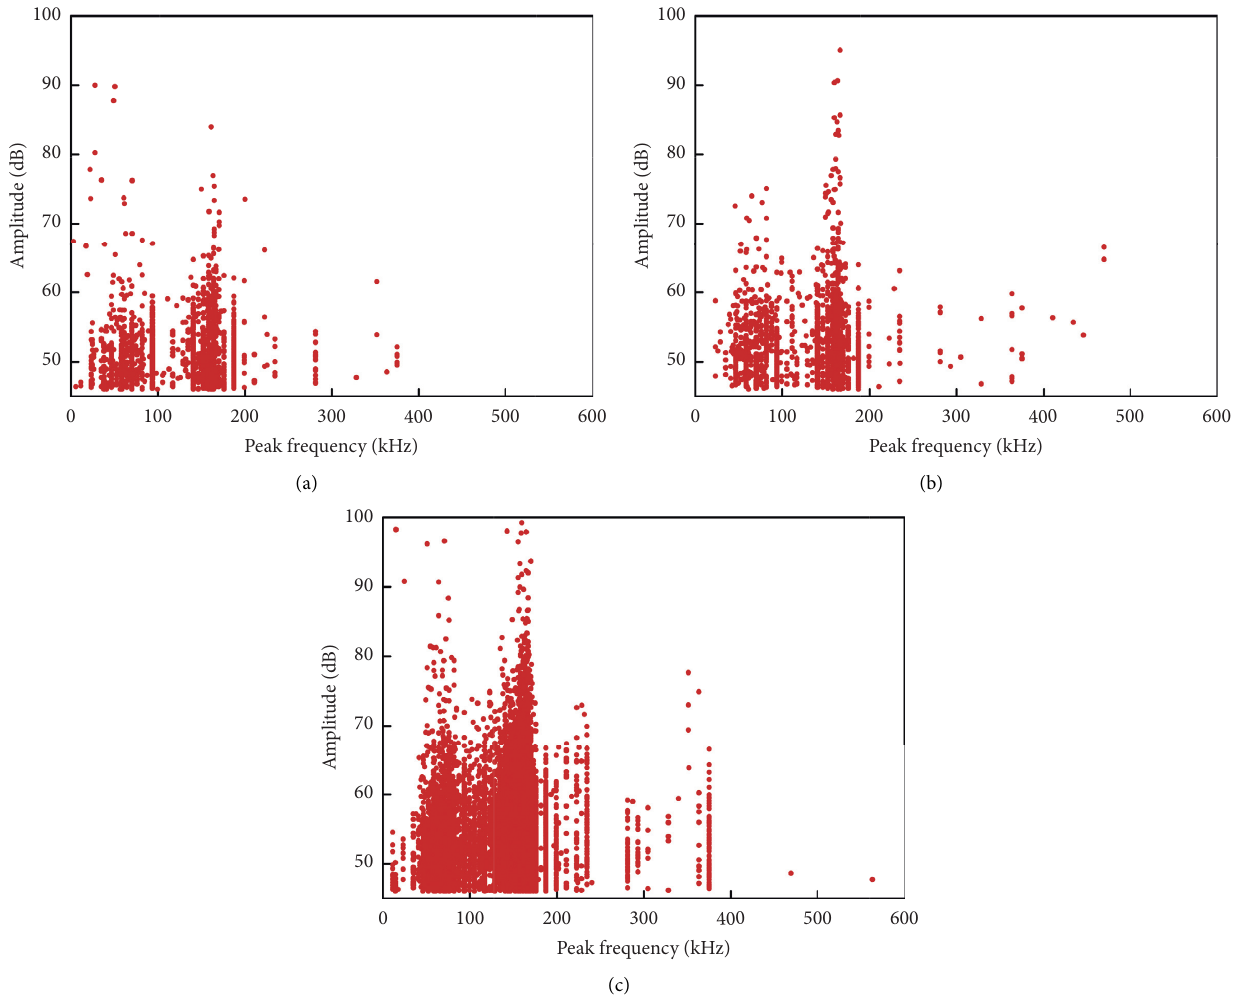
Figure 10: Peak frequency-amplitude distributions under different initial confining stress ((a) 10, (b) 20, (c) 30 MPa).